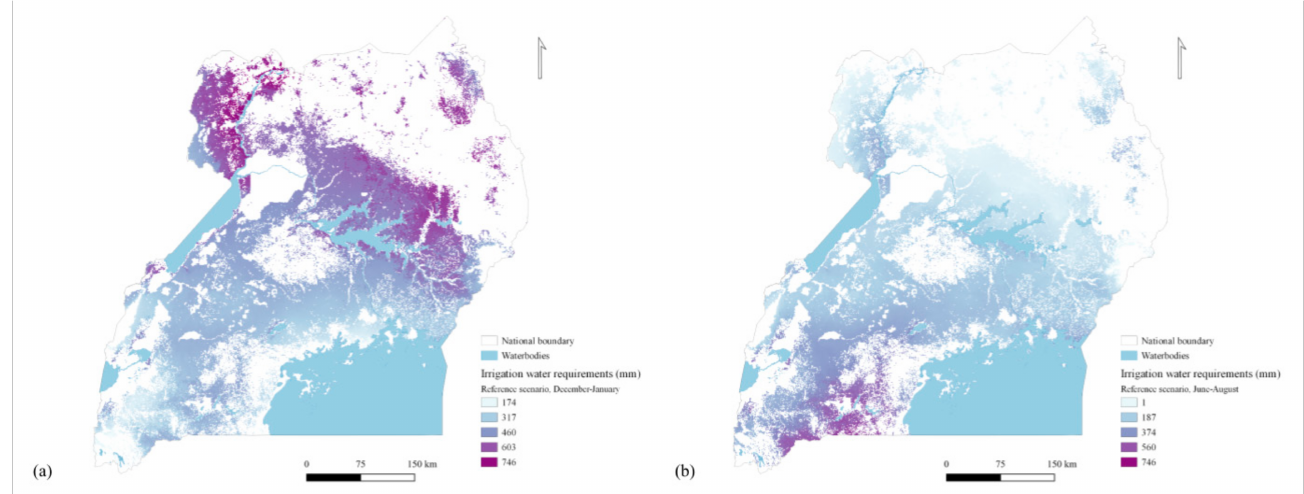
Figure 5. Aggregated irrigation water requirements in the reference scenario for the periods of December through February and June through August, respectively. The results are presented as follows: ( a ) December through January and ( b ) June through August. A notably higher demand is observed in the northern part of the study area from December through January, while there is a generally higher demand in the south from June through